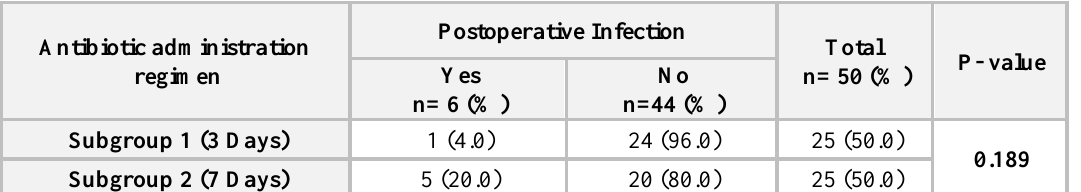
Table (4): The association between antibiotic administration regimen (Group A & B) and postoperative incidence of infection.